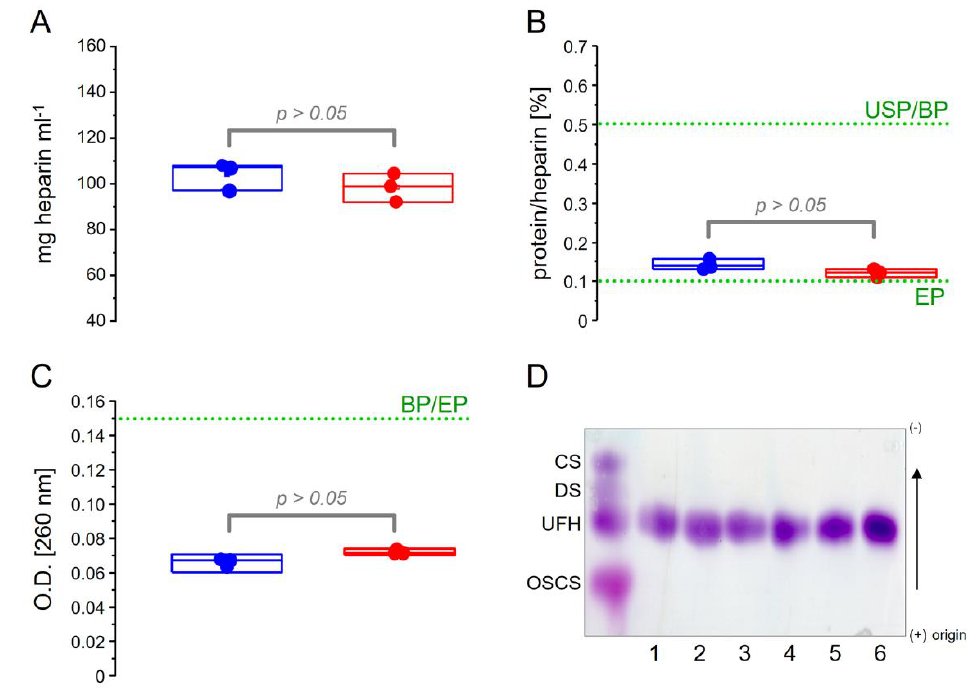
Figure 2. Hexuronic acid ( A ), protein ( B ), and nucleic acid ( C ) contents of the three batches of heparin from each manufacturer 1 ( blue ) and manufacturer 2 ( red ). The broken lines in green indicate the limits accepted by the US (USP), Brazilian (BP), and European (EP) Pharmacopeias. Panel ( D ) shows the agarose gel electrophoresis of the heparins stained with toluidine blue. Electrophoretic migration of chondroitin 4 – sulfate (CS), dermatan sulfate (DS), sodium heparin (UFH), and oversulfated chondroitin sulfate (OSCS) are indicated on the panel.